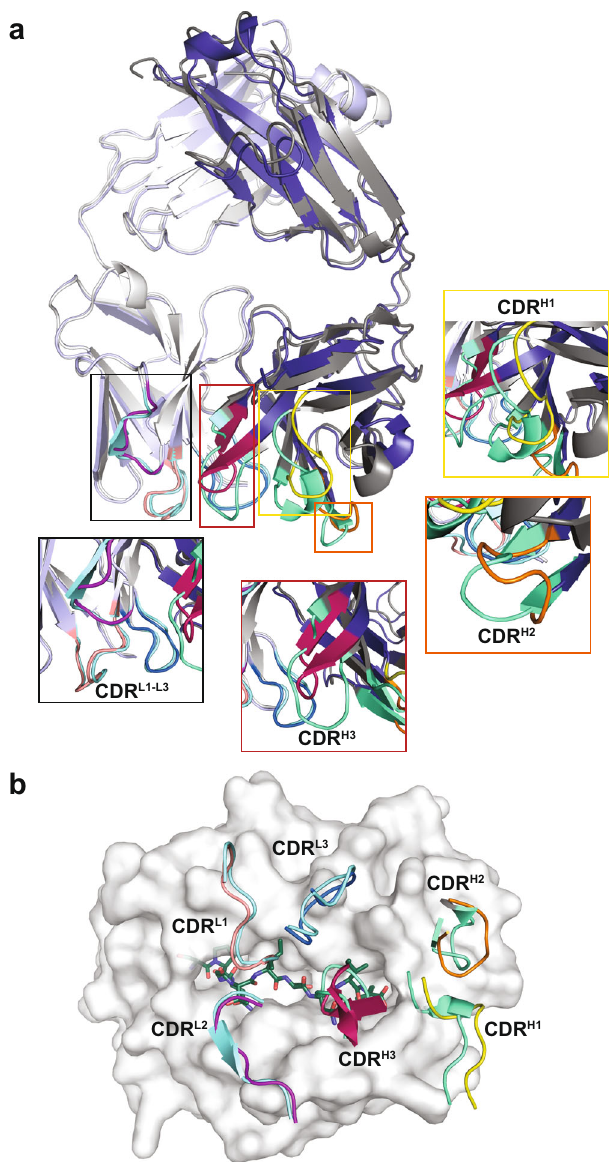
Fig. 4 2Q1-Fab free form structure. a Structural alignment of the free 2Q1- Fab (gray) with the 2Q1-Fab bound to the IDH2 R140Q -HLA-B*07:02 (Light Chain: light blue; Heavy Chain: deep blue). All CDR loops of the free 2Q1-Fab are colored in green. Zoomed views of the CDR loops are highlighted in boxes with CDR-H1 (yellow), -H2 (orange), and -H3 (raspberry) displaying the largest conformation changes. b Bird ’ s-eye view of surface representation of the HLA-B*07:02 showing the positions of the 2Q1-Fab CDR loops. The CDRs of the free 2Q1-Fab structure are overlaid with the bound 2Q1-Fab to highlight the conformational change induced upon pHLA binding. The CDRs of the free 2Q1-Fab are shown in light blue (light chain) and pale green (heavy chain). The CDR loops of the bound 2Q1-Fab are colored as in ( a